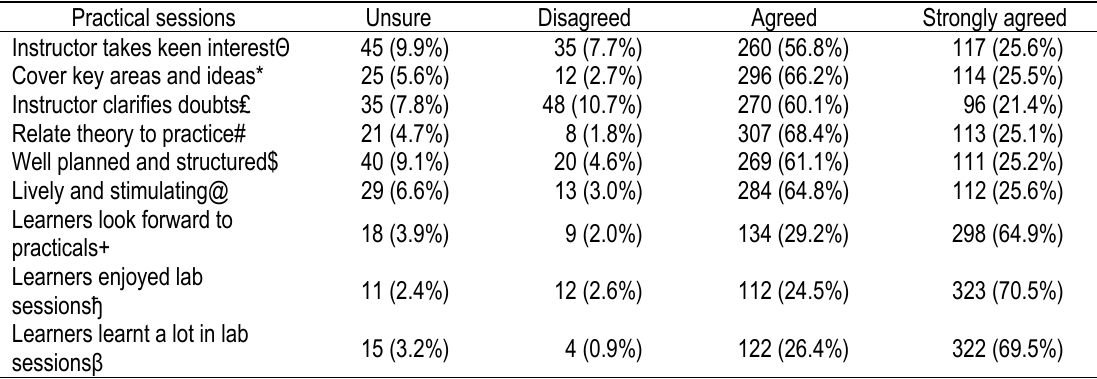
Table 6. Learner Responses on Practical